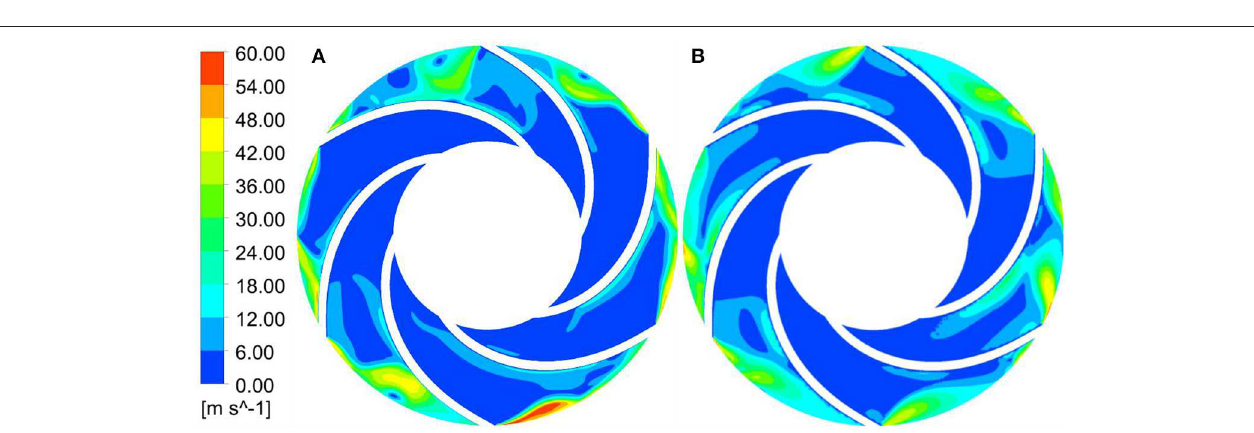
FIGURE 8 | Velocity distribution of the first stage impeller with n = 2985 r/min. (A) Start-up transient of closed-valve and (B) steady state at the same speed.